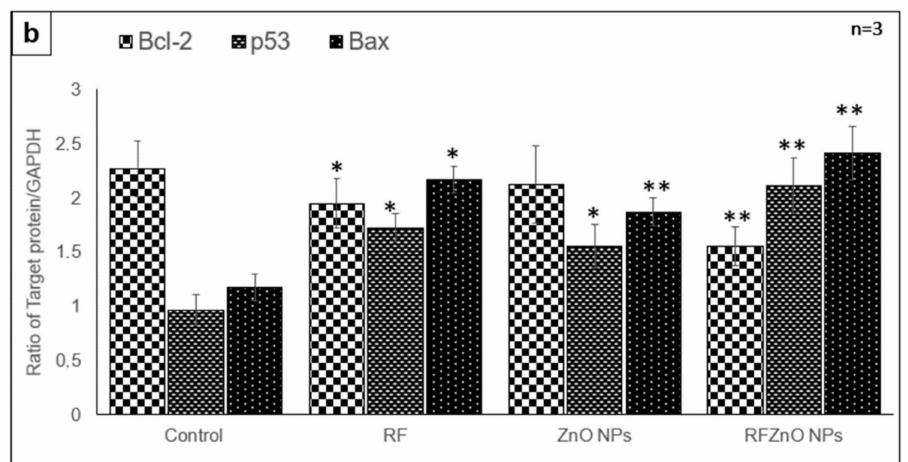
Figure 6. Effect of RFZnO NPs on the level of p53, Bax, and Bcl-2 apoptotic proteins, as determined by immunoblotting ( a ). L1: control; L2: Rubus fairholmianus (RF) (10 µ g/mL); L3: zinc oxide nanoparticles (ZnO NPs) (10 µ g/mL); L4: R. fairholmianus capped zinc oxide nanoparticles (RFZnO NPs) (10 µ g/mL). The results showed that p53 and Bax levels were significantly increased, while the level of Bcl-2 was decreased in treated groups. Relative expression shown in a graph ( b ). Protein levels were quantified using ImageJ software and normalized to GAPDH band intensity. Significant differences are shown as * p < 0.05 and ** p < 0.01. Results represent the mean ± SE of three independent